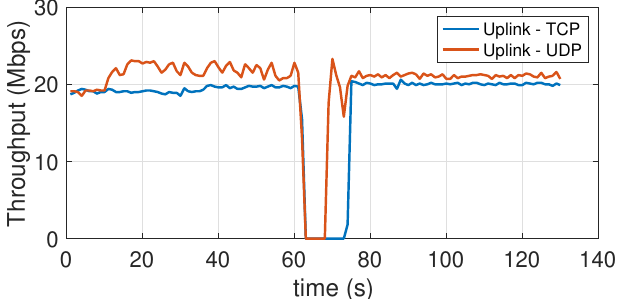
Figure 19. Uplink throughput during an handover across close-by attocells. TCP and